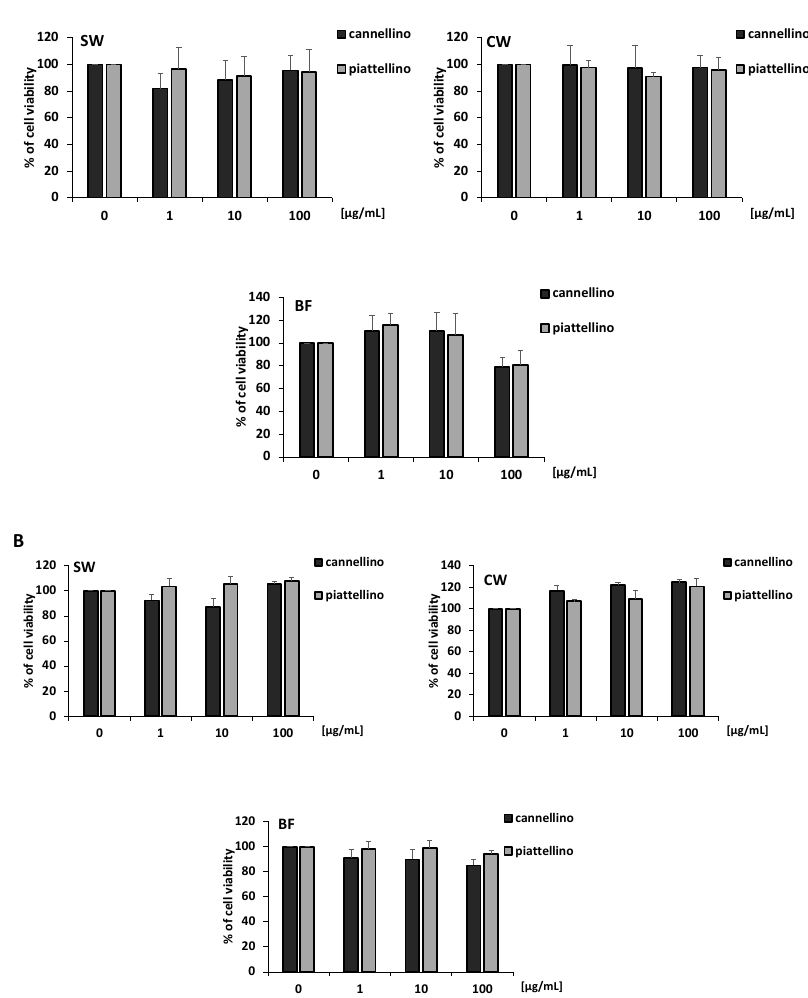
Figure 5. BF does not affect human fibroblasts and Hacat cells’ vitality. Cell vitality was measured in the presence or absence of Cannellino and Piattellino BF (1, 10, and 100 µ g/mL) by MTT assay. HF ( A ) and HaCaT ( B ) cells were exposed to treatments for 48 h. Data are reported as % of cell viability and are the means of three experiments run in